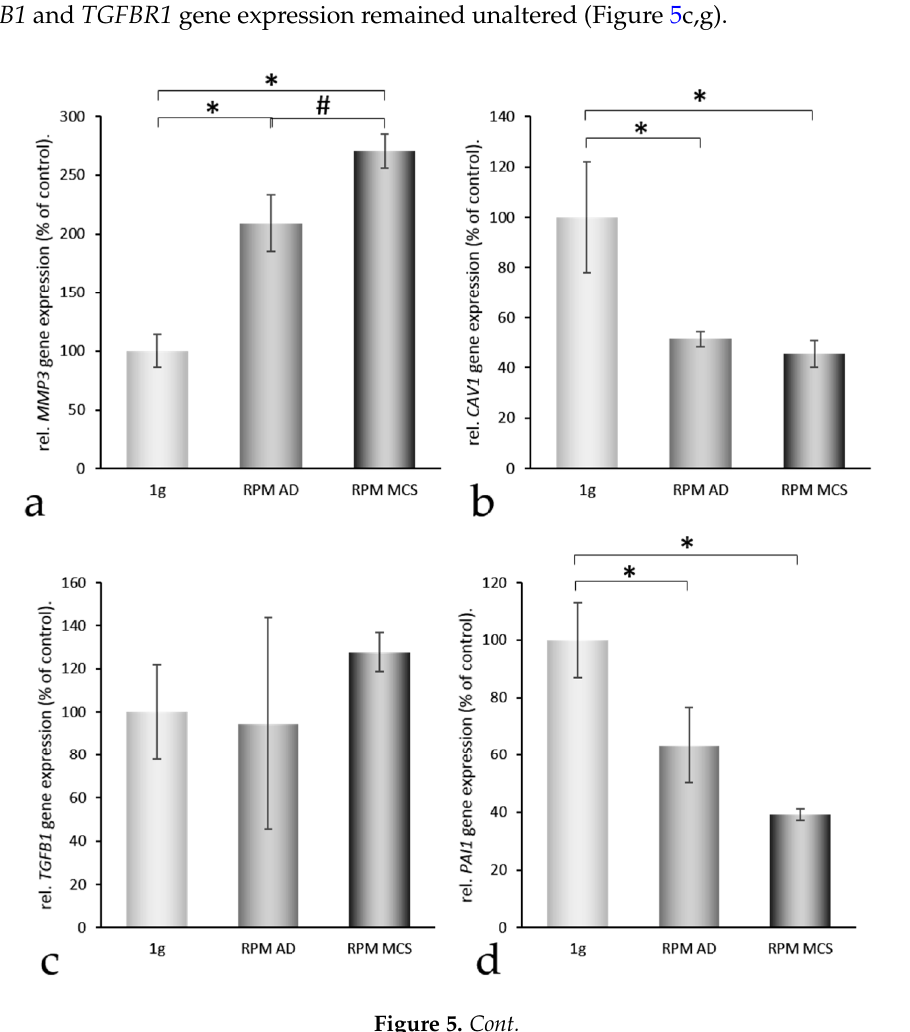
Figure 5. Cont . Figure 5.